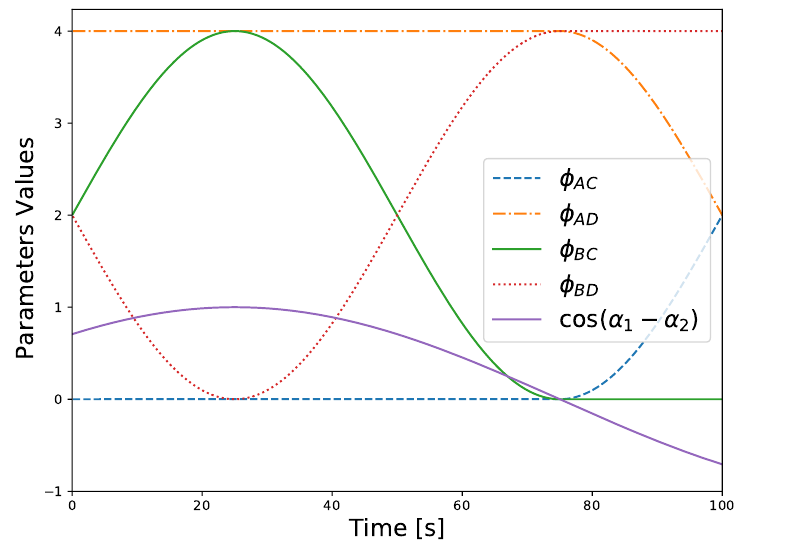
Figure 6. Relation between candidates for R I